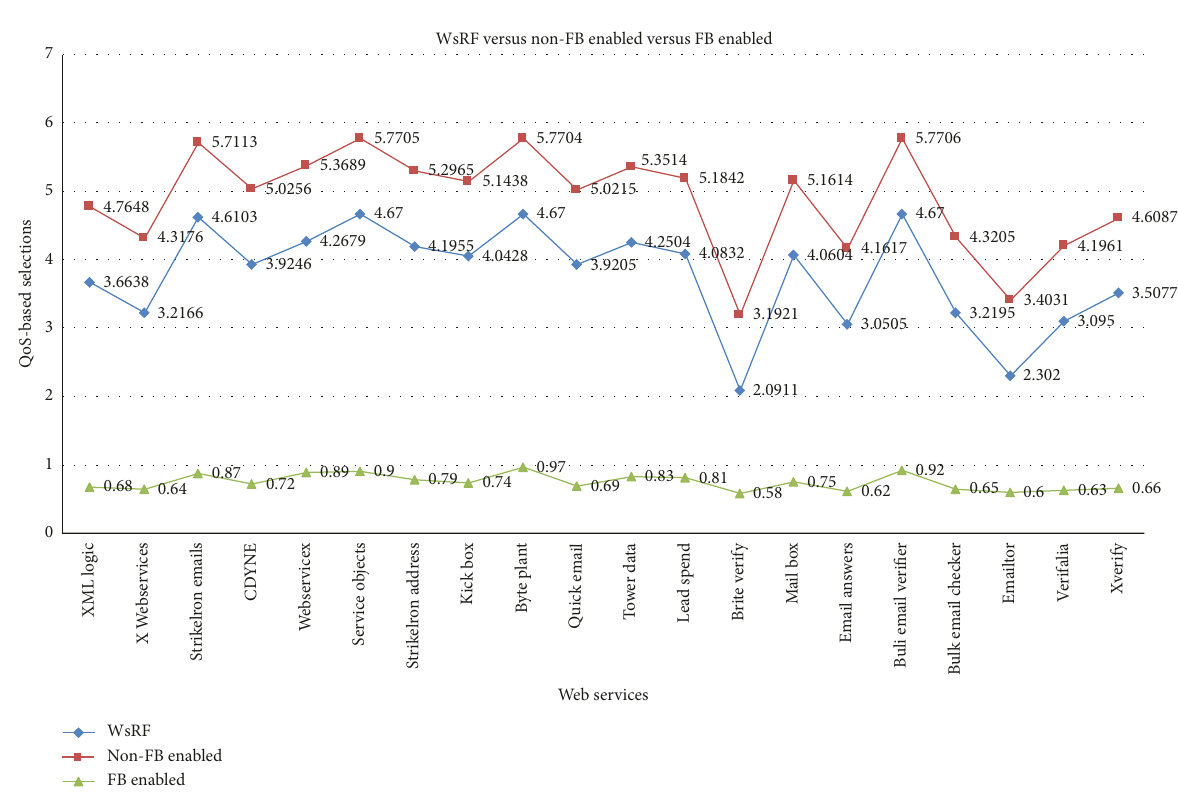
Figure 9: The comparison of WsRF, non-FB, and FB-enabled web service